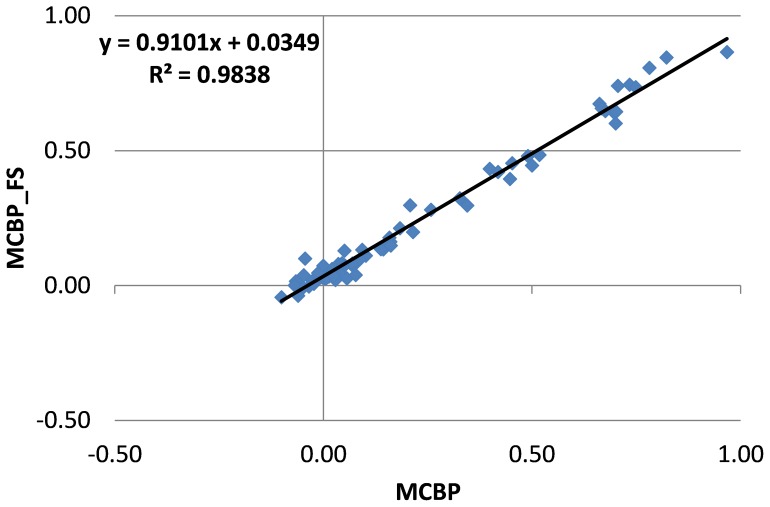
Scatter plot of MCBP values obtained using manually and FreeSurfer defined ROIs (previously shown in [47]).